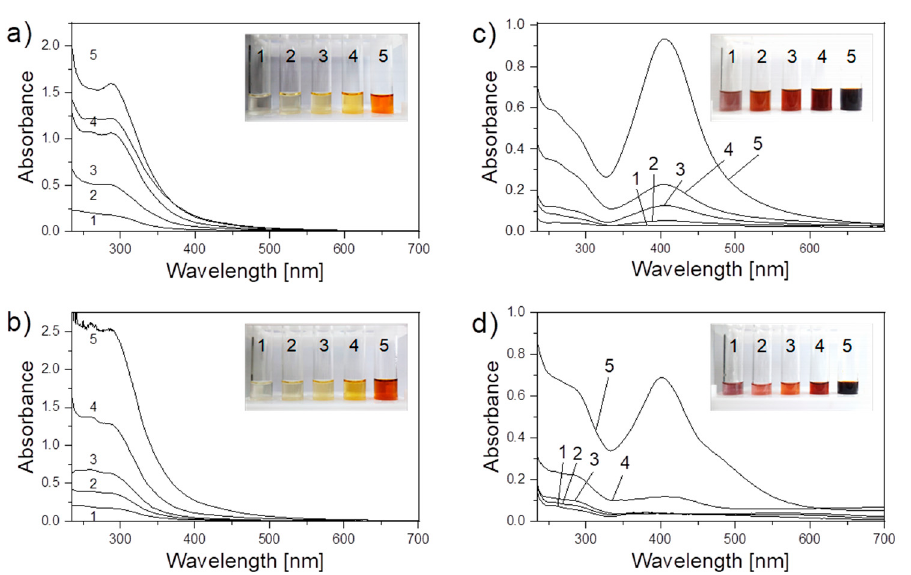
Figure 3. UV–VIS spectra of blank chitosan solution (left) and chitosan / AgNO 3 solution (right) after the plasma processing by discharge with ( a , c ) liquid anode and ( b , d ) liquid cathode during the following: 1, 0 min; 2, 5 min; 3, 10 min; 4, 15 min; and 5, 30 min. The photos of solutions as they are attached as inserts .